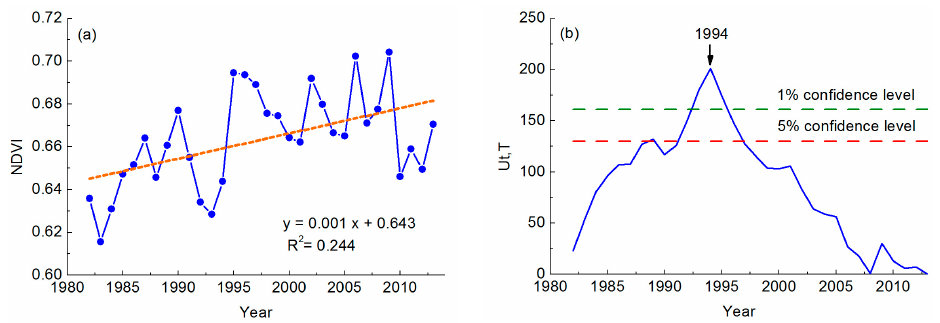
Figure 8. The variation of annual Normalized Difference Vegetation Index (NDVI) series ( a ) and change point test of annual NDVI series ( b ) in the URRB during